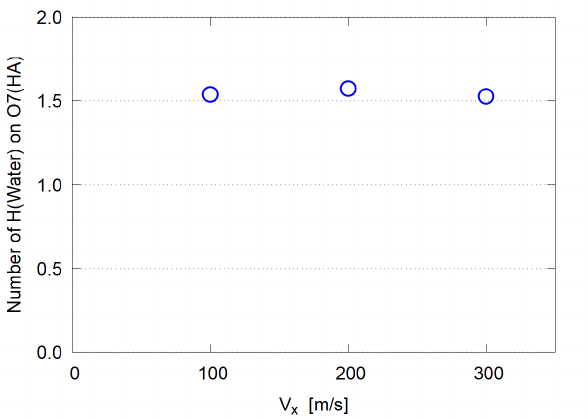
Figure 10. Average number of water molecules bound to HA:O7 sites.